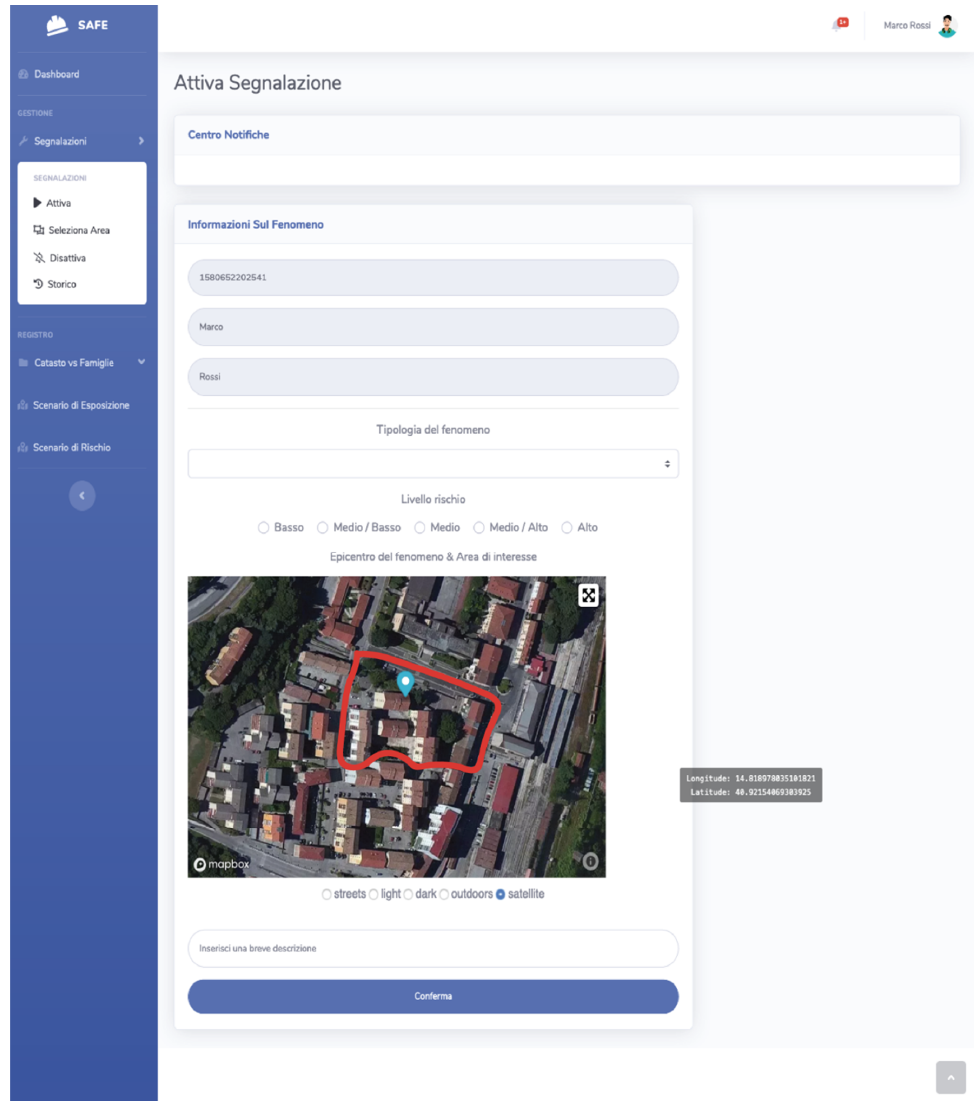
Figure 16. Drawing the area of interest associated to the new alert.